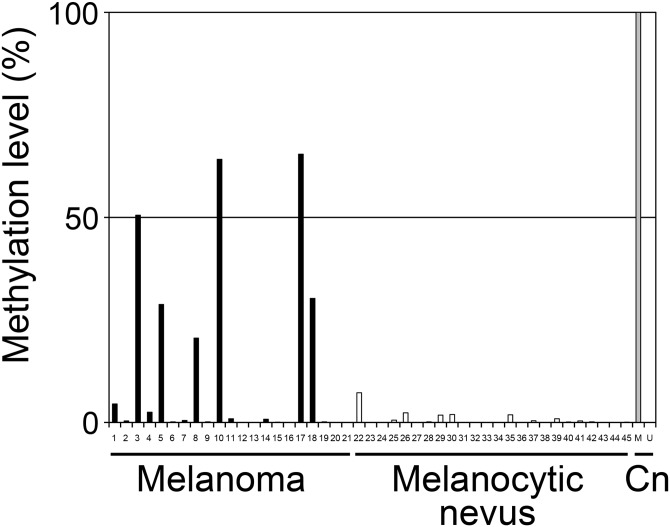
Methylation levels of the CGI located in the 5' region of IRF6 in 21 clinical melanoma samples and 24 clinical melanocytic nevus samples.Each methylation level was determined using RT-MSP. The vertical and horizontal axes indicate the methylation level (%) and sample ID, respectively. M and U indicate controls of methylated and unmethylated DNA, respectively.